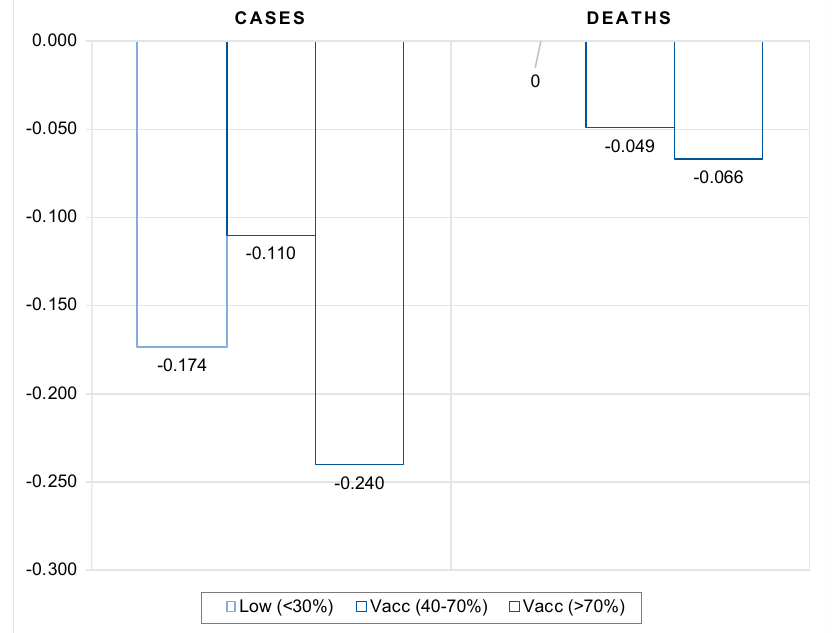
Figure 7. Impact of vaccination threshold rate on the number of new cases and deaths, all countries. Notes: Figure contains the estimated elasticities of the per-million number of new COVID cases and deaths to vaccination rate obtained by estimating the models (1) and (2). The elasticities in the figure are calculated as a sum of vaccination coefficient and the corresponding interaction terms with the vaccination group. The vaccination variable is lagged by 4 weeks. See Table A7 in the Appendix A for the full results and different lags structure.